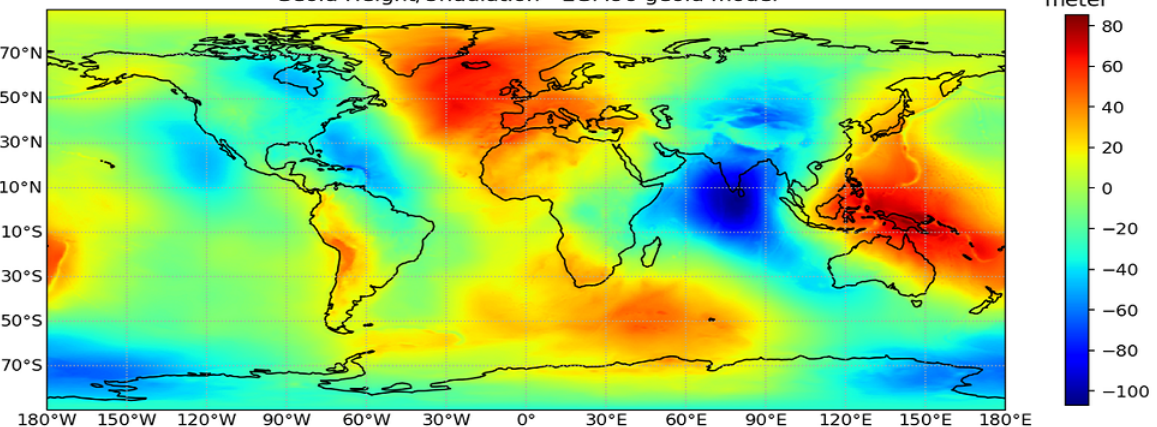
Figure 3. Selecting an appropriate vertical datum for height measurements at or above the earth’s surface is crucial, as the Geoid (mean sea level) and the WGS84 reference ellipsoid can vary by as much as 100 ±